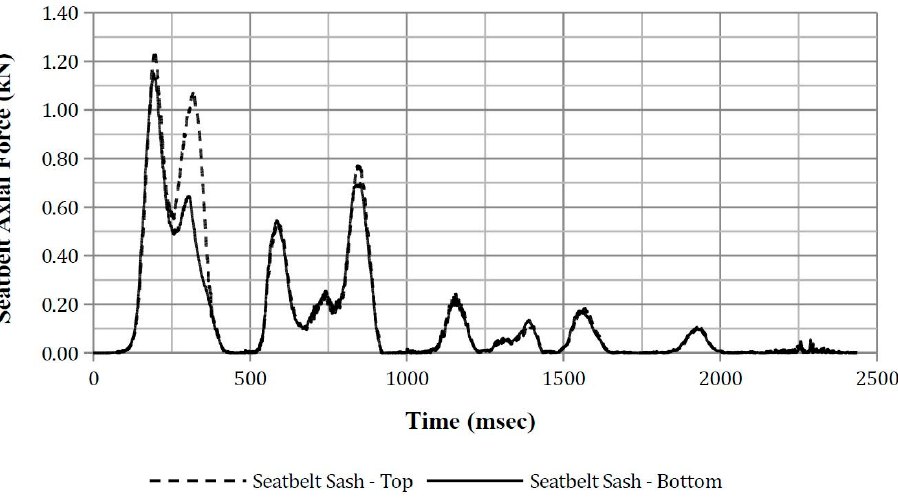
Figure A35. ATD Position 5 sash belt axial force.